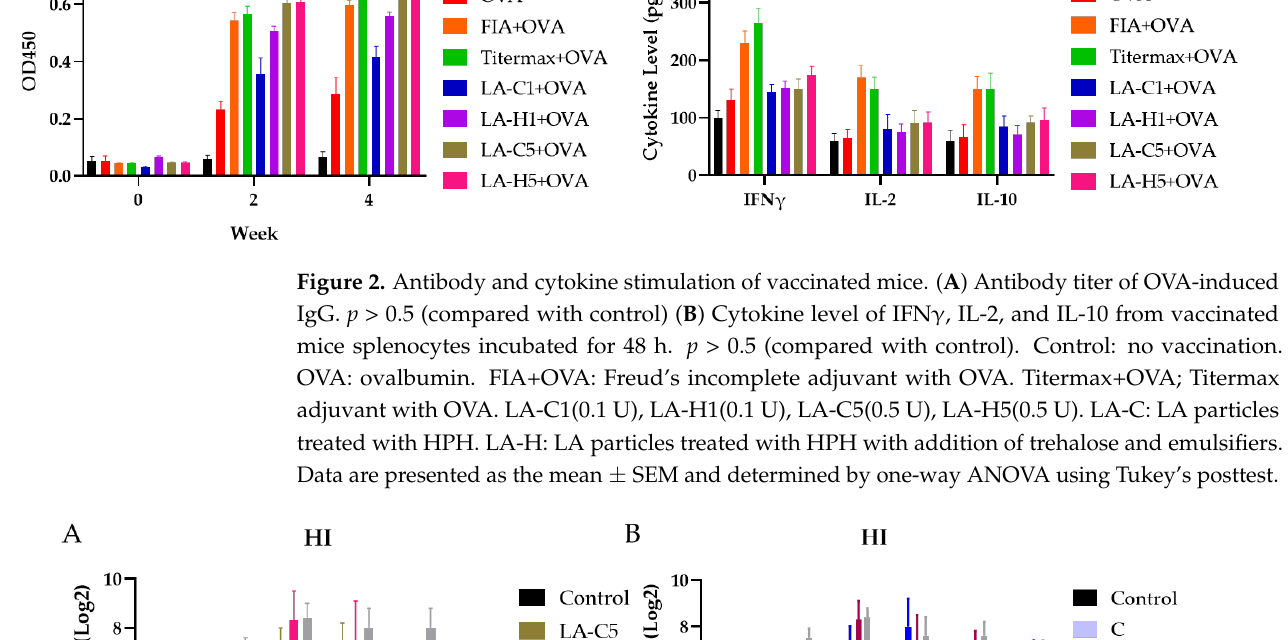
Figure 2. Antibody and cytokine stimulation of vaccinated mice. ( A ) Antibody titer of OVA-induced IgG. P > 0.5 (compared with control) ( B ) Cytokine level of IFNγ, IL -2, and IL-10 from vaccinated mice splenocytes incubated for 48 h. P >0.5 (compared with control). Control: no vaccination. OVA: ovalbumin. FIA+OVA: Freud’s incomplete adj uvant with OVA. Titermax+OVA; Titermax adjuvant with OVA. LA-C1(0.1 U), LA-H1(0.1 U), LA-C5(0.5 U), LA-H5(0.5 U). LA-C: LA particles treated